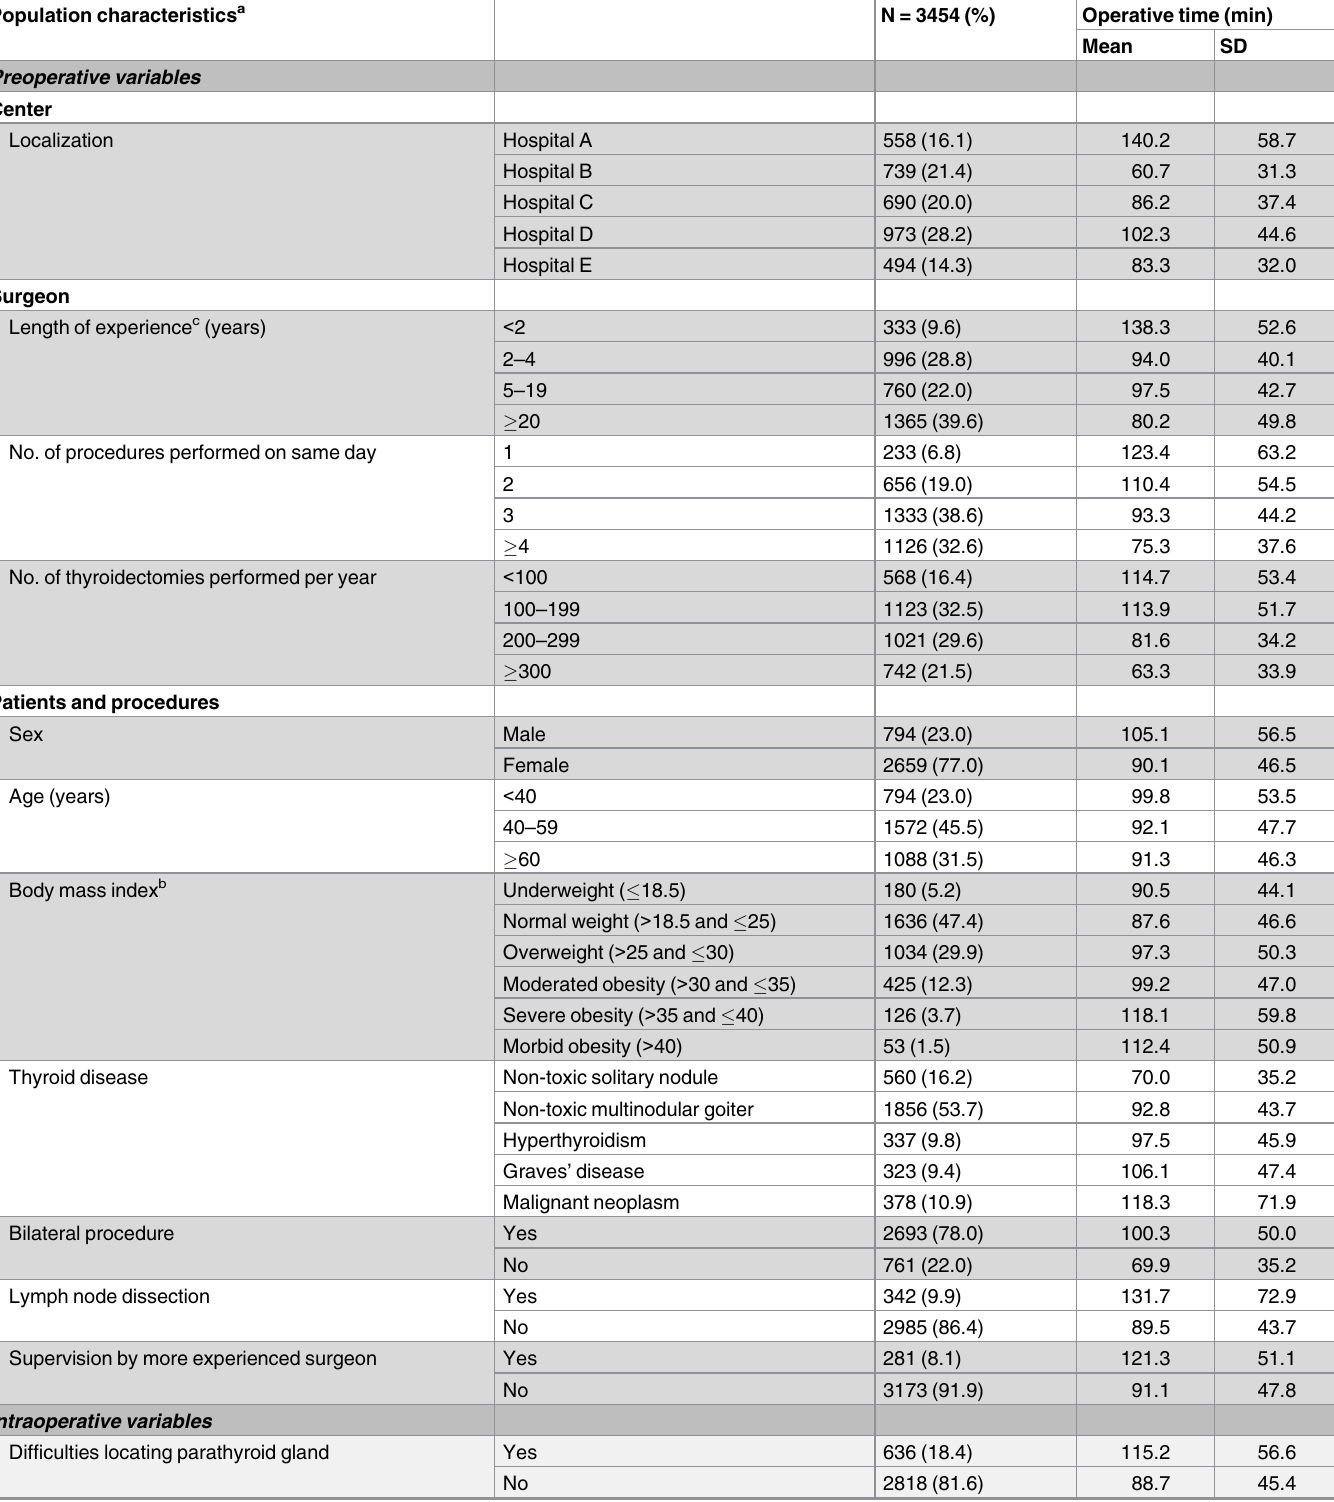
Table 1. Operative time by population